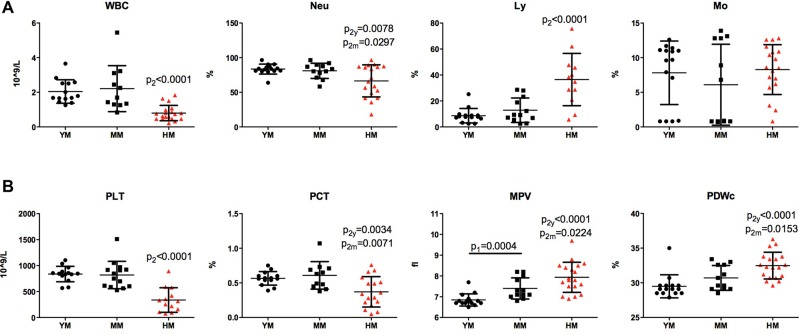
Irradiation and humanization induced changes in white blood cells and platelets counts of NSG mice. (A) Comparison of peripheral white cell count (WBC) and differentials (neutrophils, Neu; lymphocytes, Ly; monocytes, Mo) between young 6 month old (YM), middle age 12 month old (MM) and humanized (HM) NSG mice. Significant reduction of WBC and relative decrease in Neu with significant increased Ly percentage in HM NSG mice were observed. (B) Platelet count (PLT) and plateletcrit (PCT), mean platelet volume (MPV) and platelet distribution width (PDWc) are significantly changed in HM with reduction of total number, PCT and elevation of platelet volume and distribution width. One-way ANOVA with post-hoc testing by Tukey's Multiple Comparison Test. Unpaired t-test with Welch's correction: p1 – differences between YM and MM; p2, p2y or p2m – difference between humanized and non-humanized, from YM and MM mice. Individual values, mean and s.d. are shown.